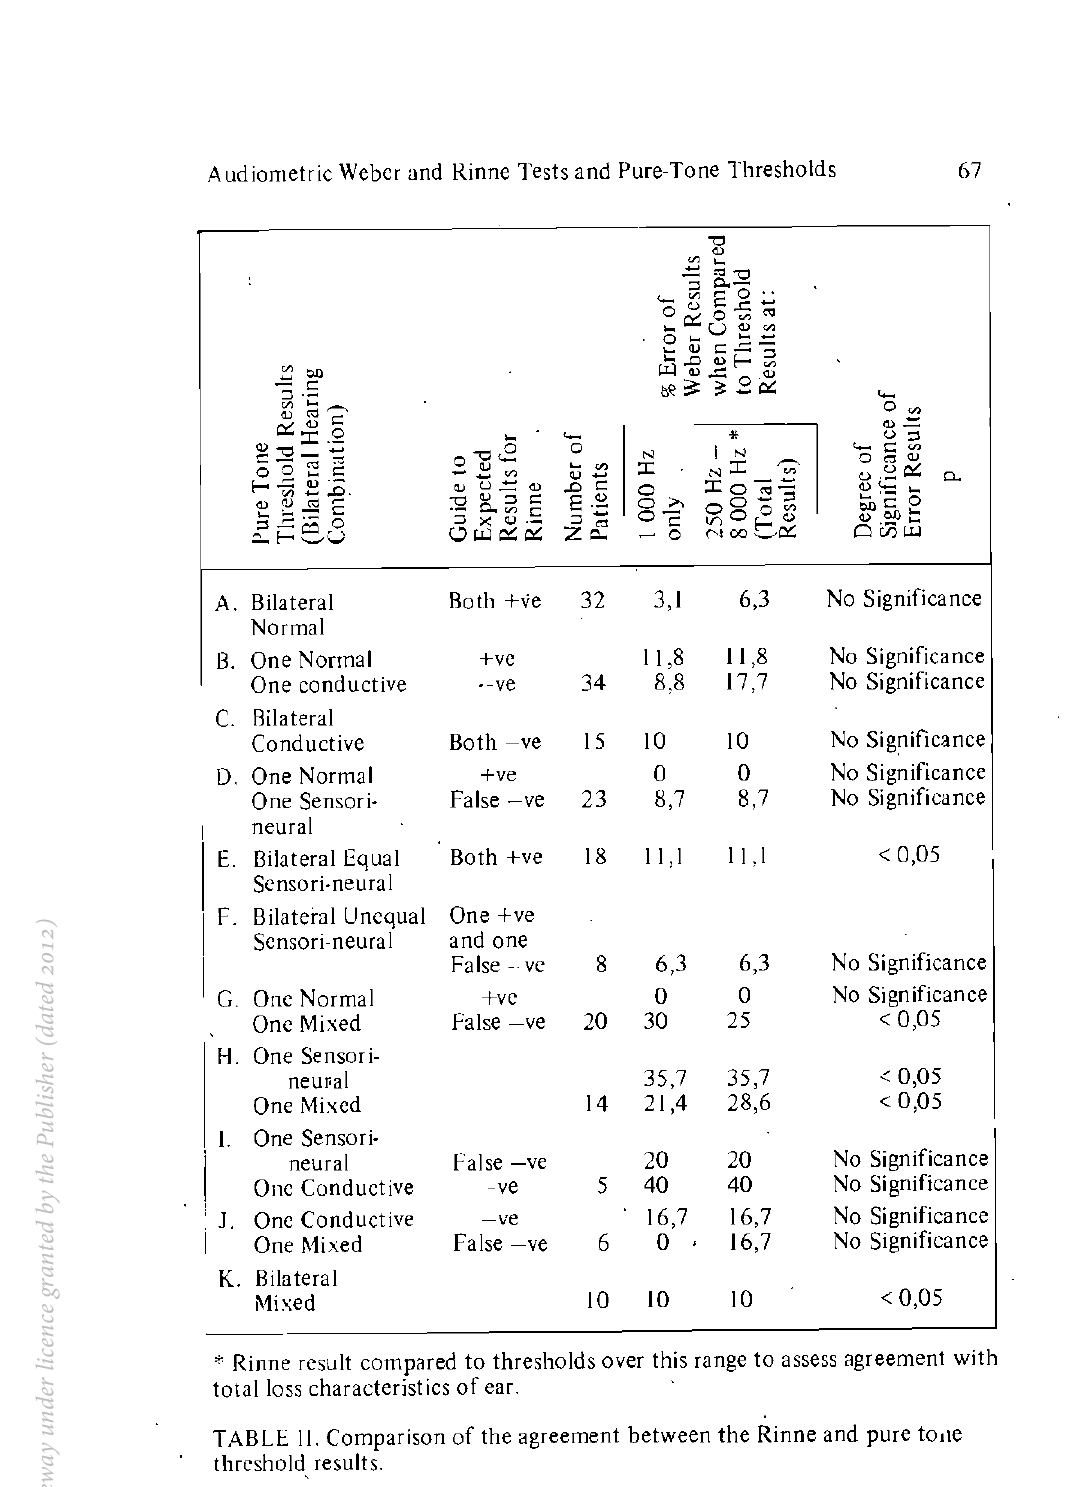
TABLE 11. Comparison of the agreement between the Rinne and pure tone threshold